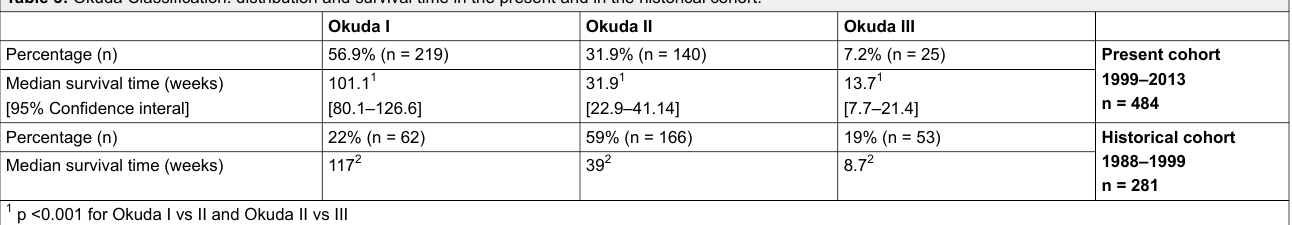
Table 3: Okuda Classification: distribution and survival time in the present and in the historical